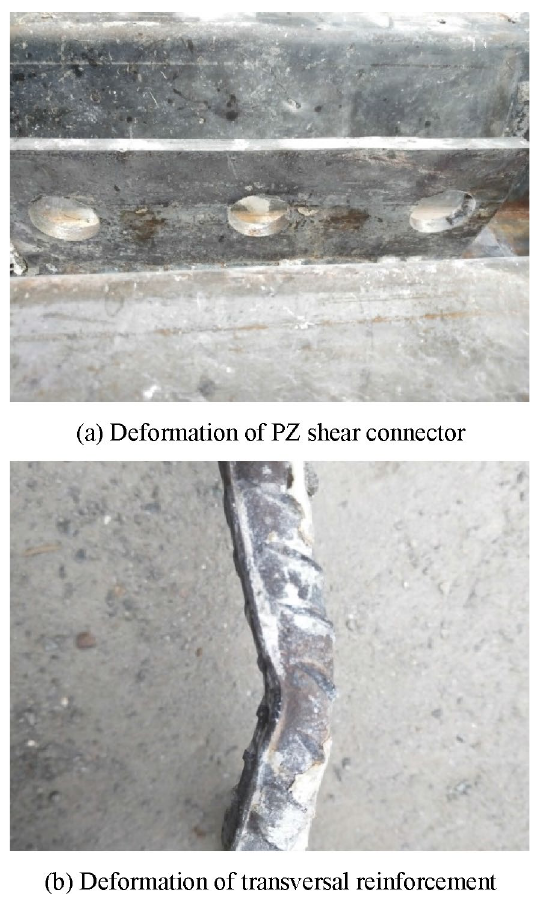
Figure 8. A specimen with PBL shear connector after